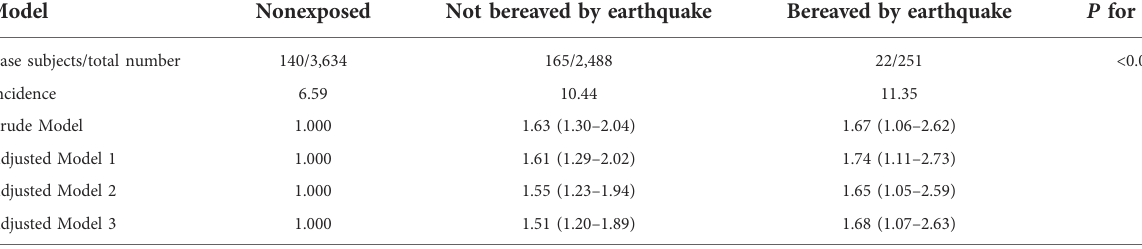
TABLE 4 Association between earthquake bereavement and risk of DM in adulthood.